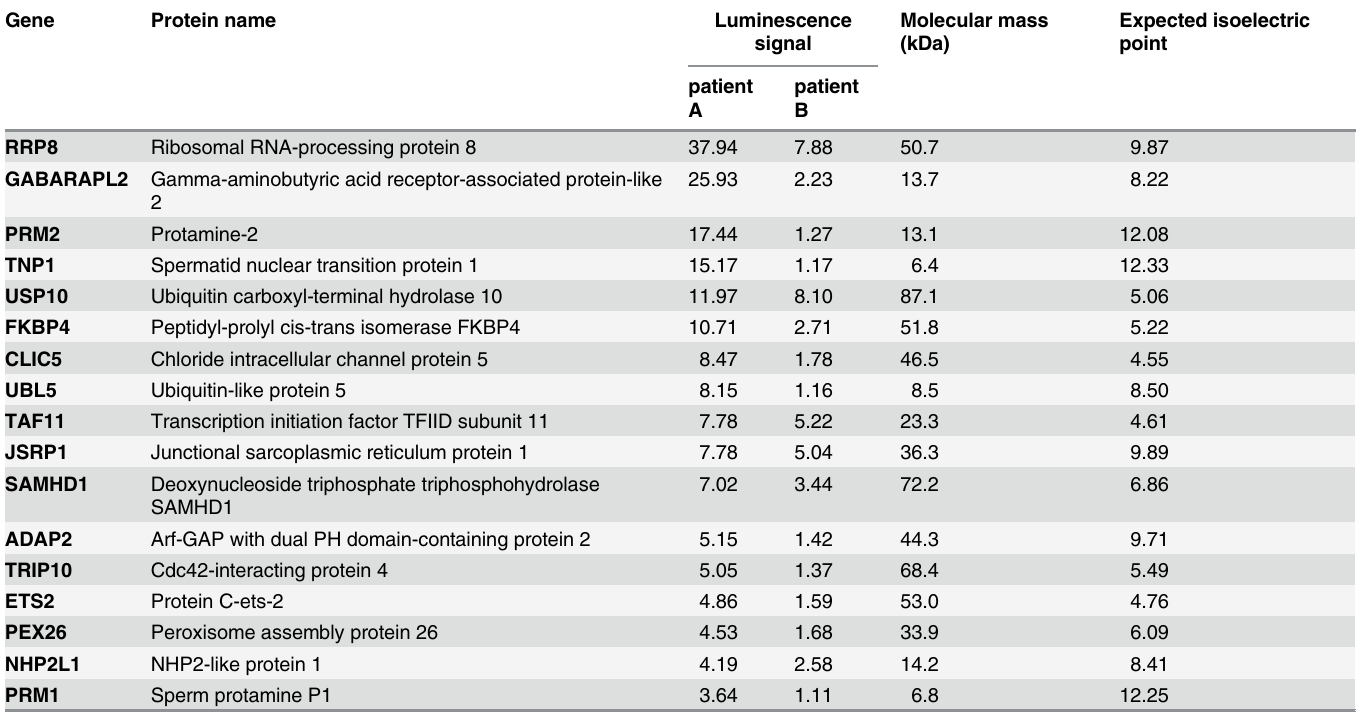
Table 1. Screening of 17 autoantigens associated with LN using a biotinylated human autoantigen library. Gene